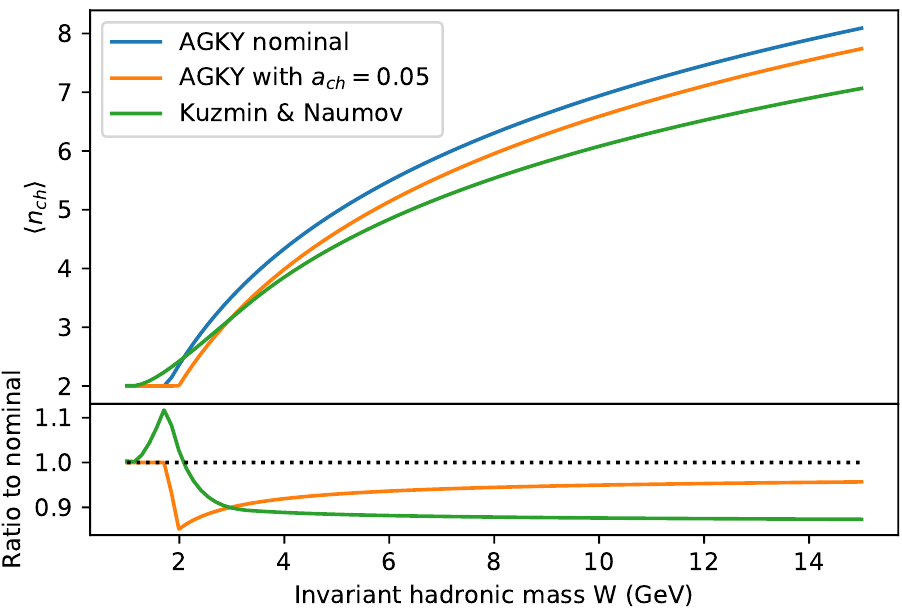
Figure 144. Impact of various fitted forms for charged hadron multiplicity on the prediction (for neutrino-proton scattering) as a function of invariant hadronic mass. GENIE’s AGKY model is blue; AGKY with the value of a ch adjusted to fix a transcription error from its source is orange; an alternative fitted form by Kuzmin and Naumov is in green.